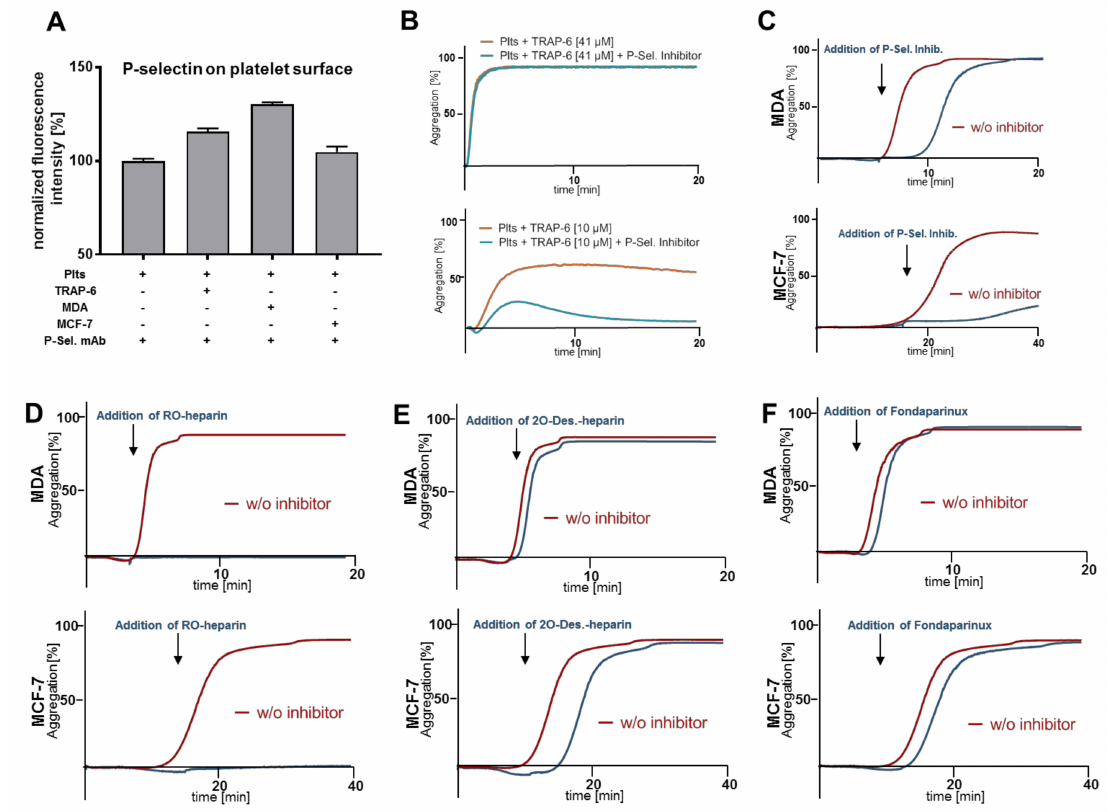
Figure 3. Impact of heparin derivatives on platelet aggregation and secretion after platelet shape change. ( A ) Platelets were stimulated with TRAP-6, MDA-MB-231, or MCF-7 cells, respectively, and P-selectin expression was determined by flow cytometry; ( B ) representative traces showing platelet-tumor cell aggregation in response to PAR-1 receptor agonist TRAP-6 (41 µ M or 10 µ M, respectively). Platelets were preincubated for 30 min with 100 µ g / mL P-selectin inhibitor ( n = 5); ( C ) representative traces showing platelet-tumor cell aggregation in response to MDA-MB-231 or MCF-7 cells, respectively. P-selectin inhibitor (100 µ g / mL) was added 5 min (10 min in case of MCF-7 cells) after tumor cell addition when platelet shape change was in progress ( n = 5); ( D – F ) representative traces showing platelet-tumor cell aggregation in response to MDA-MB-231, or MCF-7 cells, respectively, when RO-heparin (100 µ g / mL) ( D ), 2- O -desulfated heparin (100 µ g / mL) ( E ), or fondaparinux (775 ng / mL) ( F ) were added 5 min / 10 min after tumor cell addition when platelet shape change was in progress ( n =